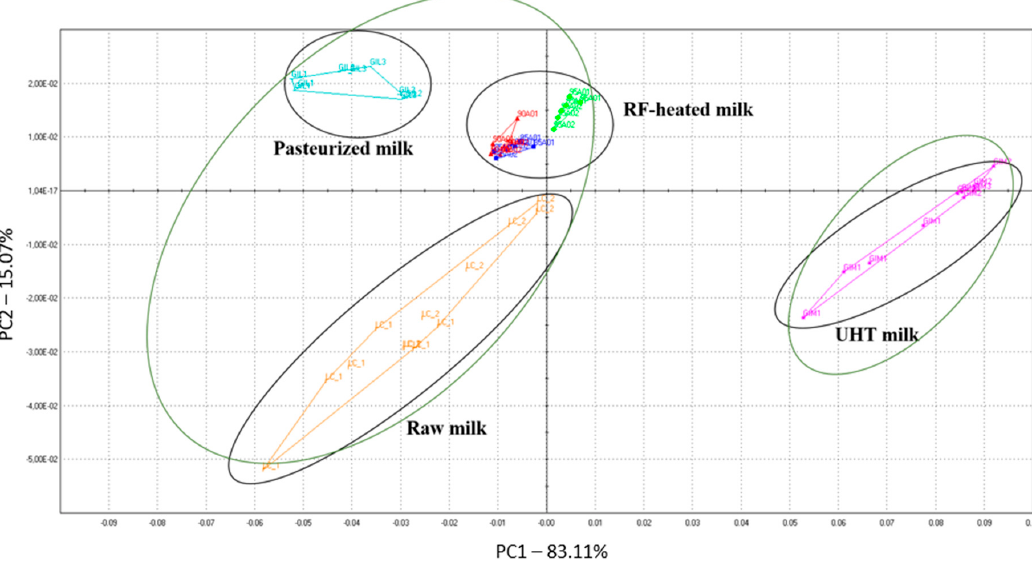
Figure 3. PCA for E-nose and E-tongue merged sensors’ outputs. Each different point within the plot refers to different treatment replicates.